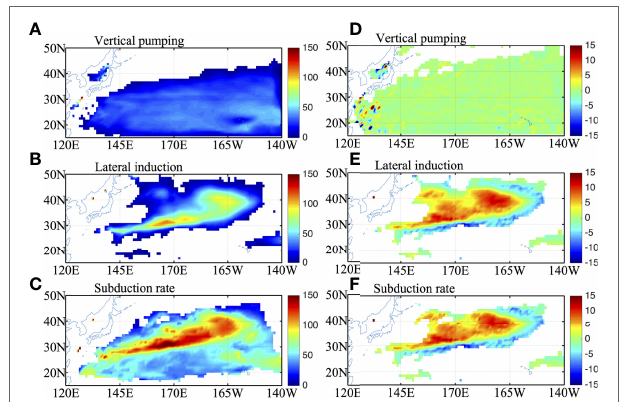
FIGURE 7 | (A) vertical pumping, (B) lateral induction and (C) the total subduction rate in NOCHL run in the north Pacific (m/year). (D–F) are the same as (A–C) but for the differences between the two experiments (CLIMCHL-NOCHL).